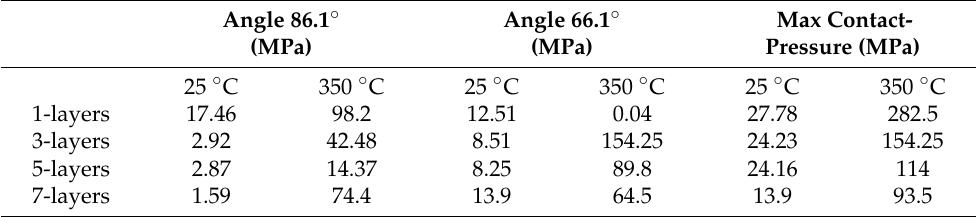
Table 3. The contact pressure of the laminated